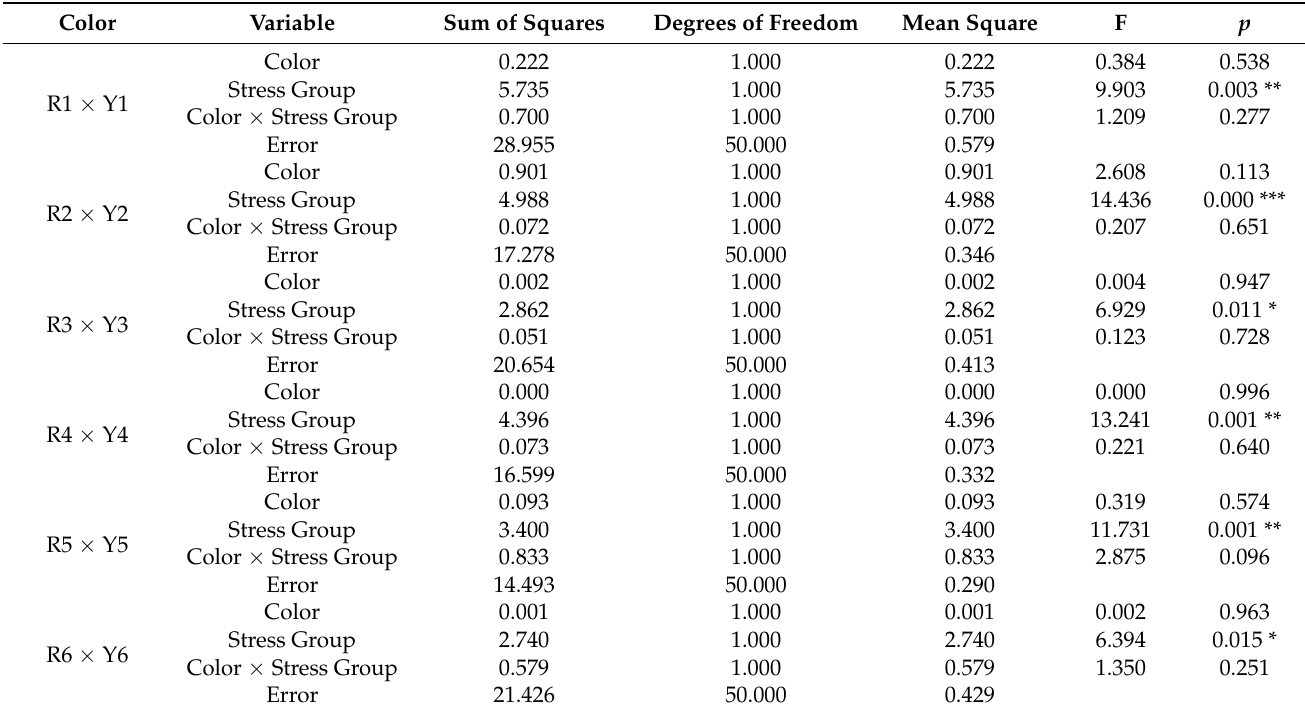
Table 11. The main effect and interaction by hue changes and stress groups of ln(LF).